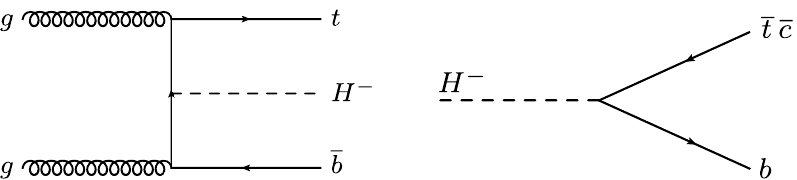
Figure 3 . Charged Higgs production in association with top and bottom quarks (left) and charged Higgs decay into up-type and bottom quarks